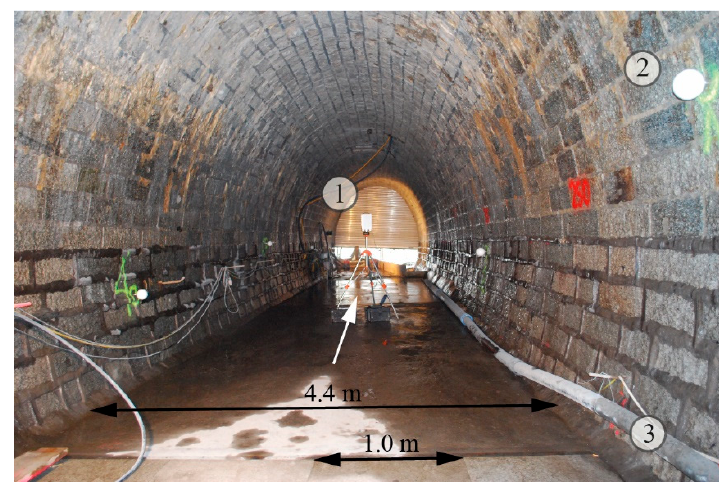
Figure 2. Measurement installation in Pfaffensprung SBT at test field location 1 during scanning in March 2014, (1) terrestrial laser scanner (TLS), (2) temporary mounted targets and (3) ground water drainage, view in flow direction from high-strength concrete (C1) over granite pavement (G1) to SBT outlet.